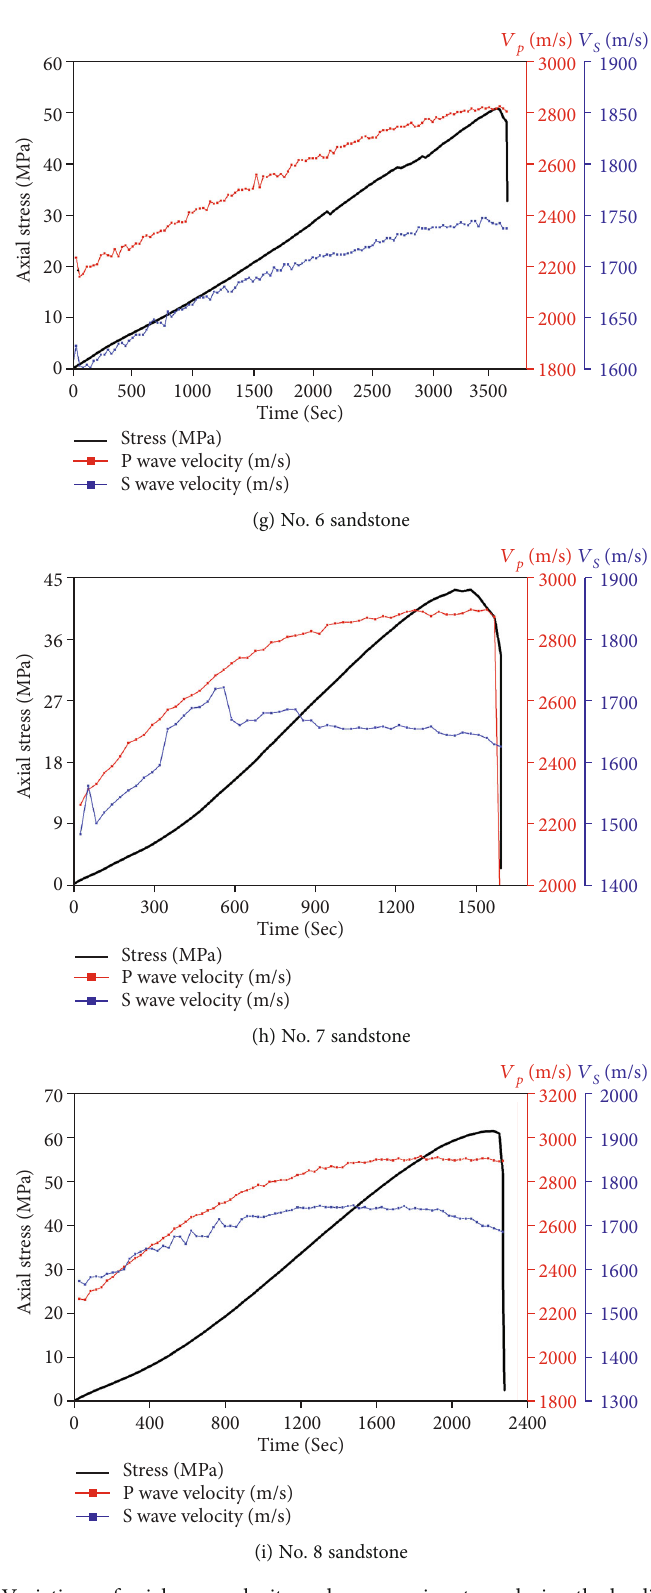
Figure 9: Variations of axial wave velocity and compressive stress during the loading